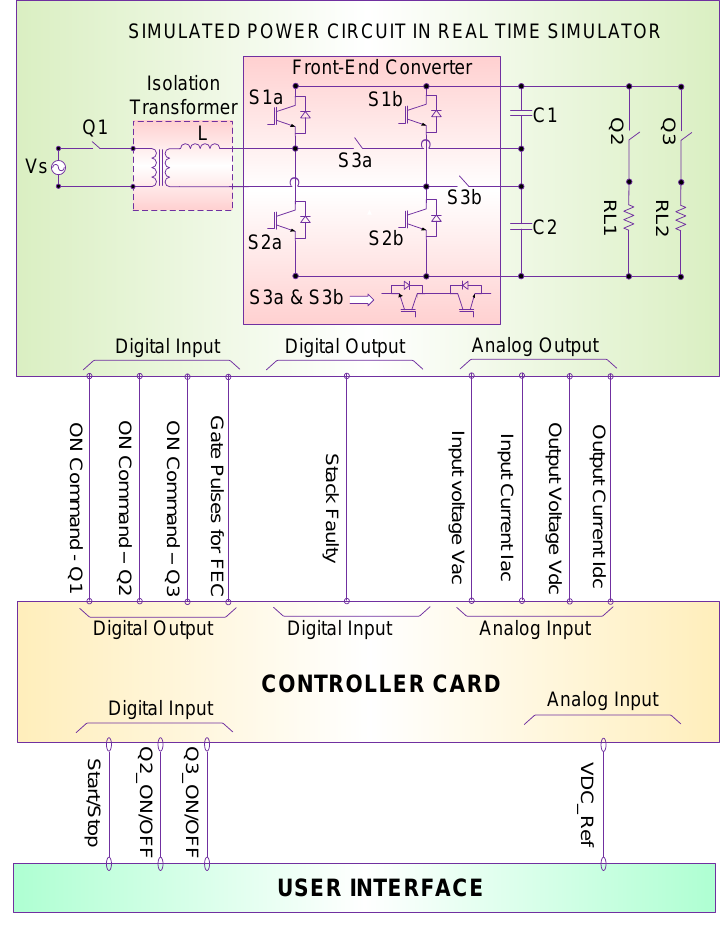
Figure 3. Electrical scheme for controller-In-Loop simulation validation of T-Type Front-End Converter. Table 3. Details of the Hardware Used in the Controller-In-Loop Simulations. SL. No.